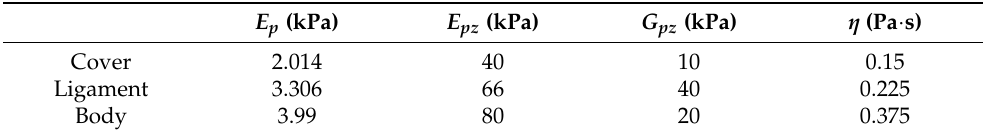
Table 1. Material properties of the inner layers of the vocal fold. E p is the transversal Young’s modulus, E pz is the longitudinal Young’s modulus, G pz is the longitudinal shear modulus, and η is the damping ratio. E p (kPa) E pz (kPa) G pz (kPa) η (Pa · s) Cover 2.014 40 10 0.15 Ligament 3.306 66 40 0.225 Body 3.99 80 20